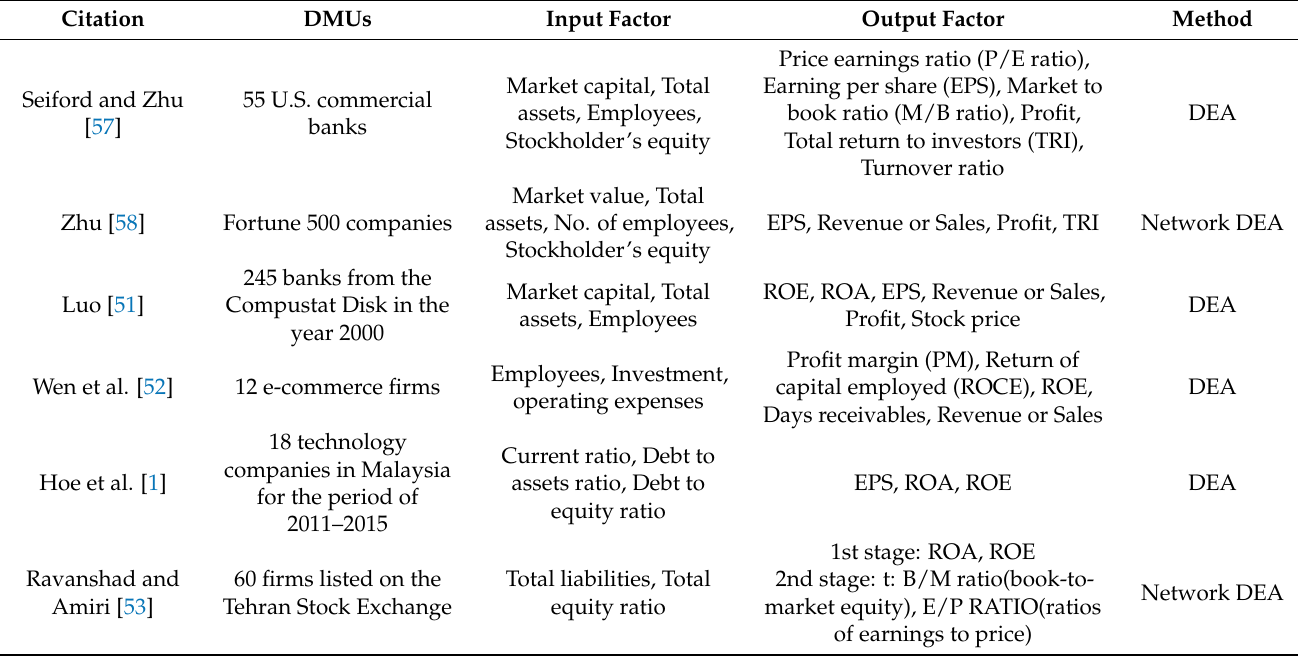
Table 1. Studies of profitability efficiency using